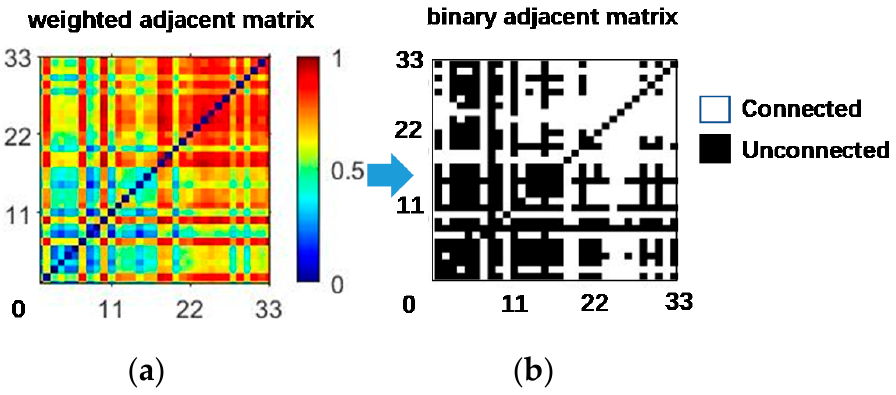
Figure 7. The adjacency matrix of the muscle function network. The weighted adjacent matrix be ‐